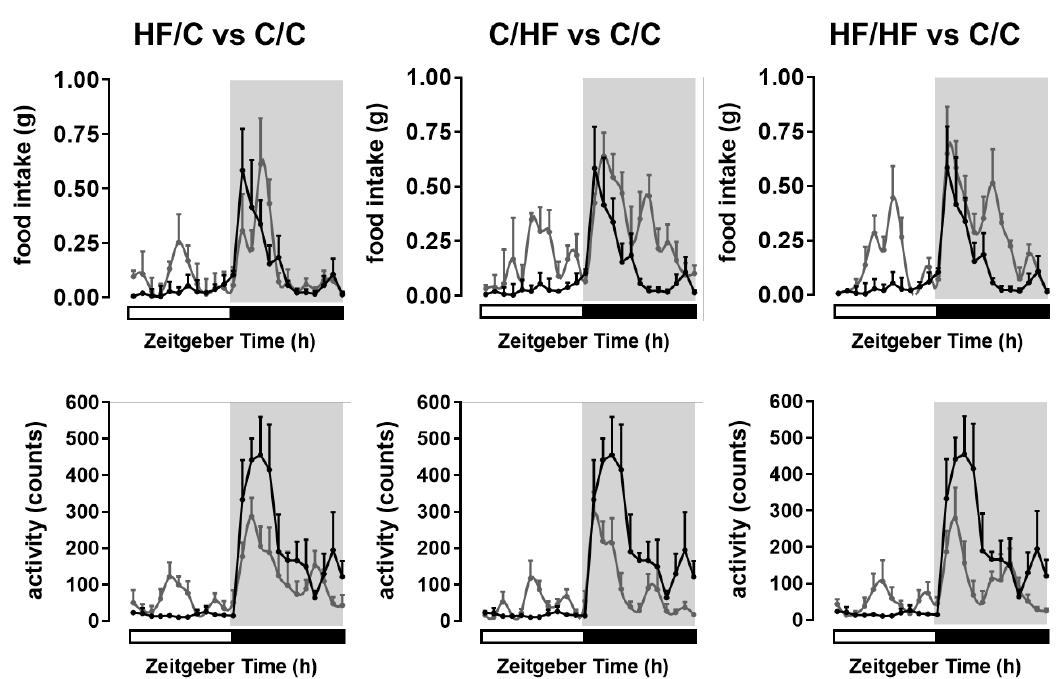
Figure 1. Maternal obesity and postweaning high-fat (HF) diet consumption alters diurnal rhythms of food intake and activity. The 24 h food intake and activity during the light – dark cycle were recorded for the offspring from lean dams and on the control (C) diet (C/C offspring, black lines) and compared with the control-fed offspring from obese dams (HF/C offspring, grey lines), or with the HF-fed offspring from lean (C/HF group) or obese (HF/HF group) dams (grey lines).